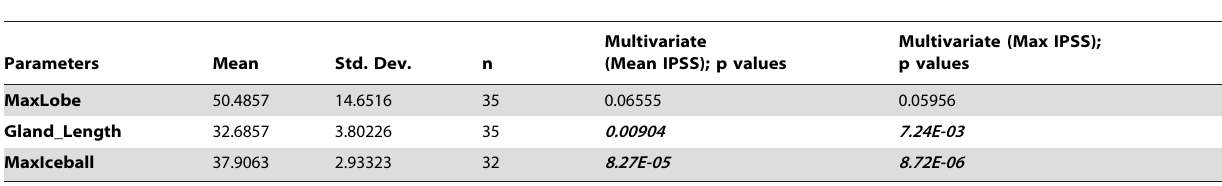
Table 5. Association between gland length and maximal length of iceball recorded with patient IPSS outcome.